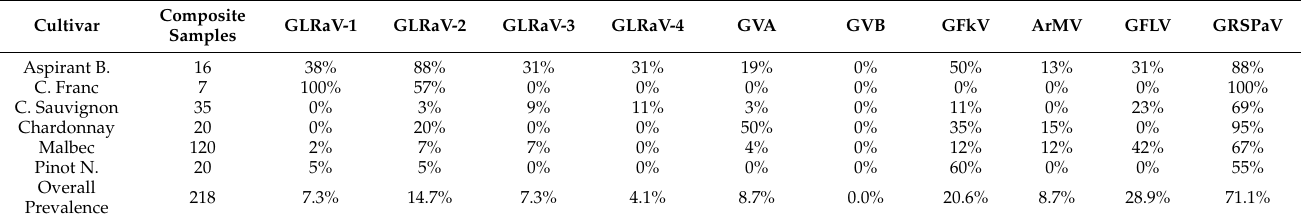
Table 2. Prevalence of grapevine viruses in composite samples of different